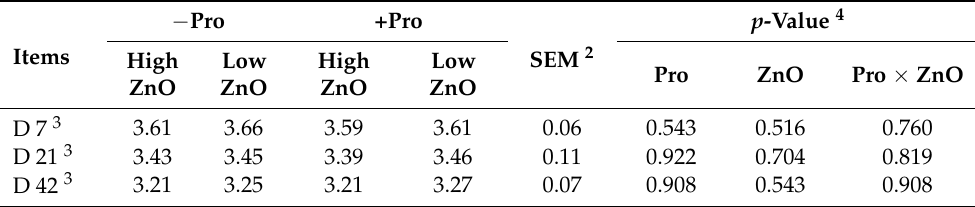
Table 4. Effects of ‘SynerZymeF10’ supplementation in ZnO diets on faecal score in weaning pigs 1